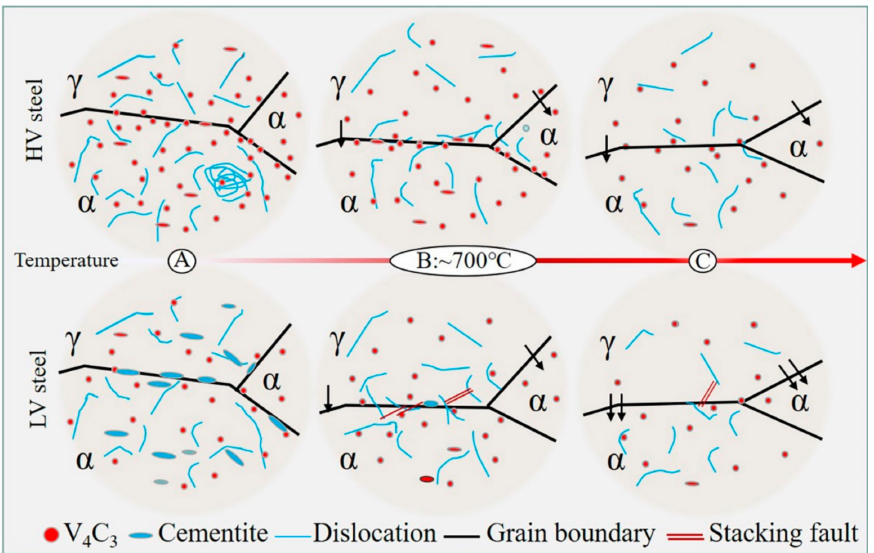
Figure 10. Schematic diagram of the phase interface evolution of HV steels and LV steels with increasing temperature. Stage A: ~600 ◦ C, stage B: ~700 ◦ C, stage C: over 700 ◦ C or